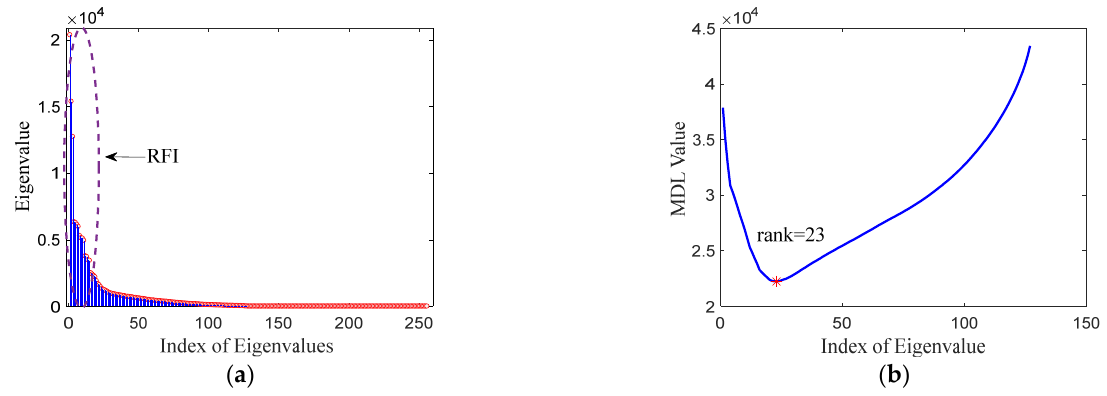
Figure 8. Eigenvalues and MDL curve of the spectrogram in Figure 7d: ( a ) the eigenvalue sequence; ( b ) the MDL function curve of ( a ).